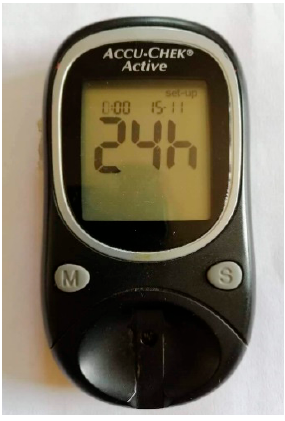
Figure 2. Digital blood glucose sensor.